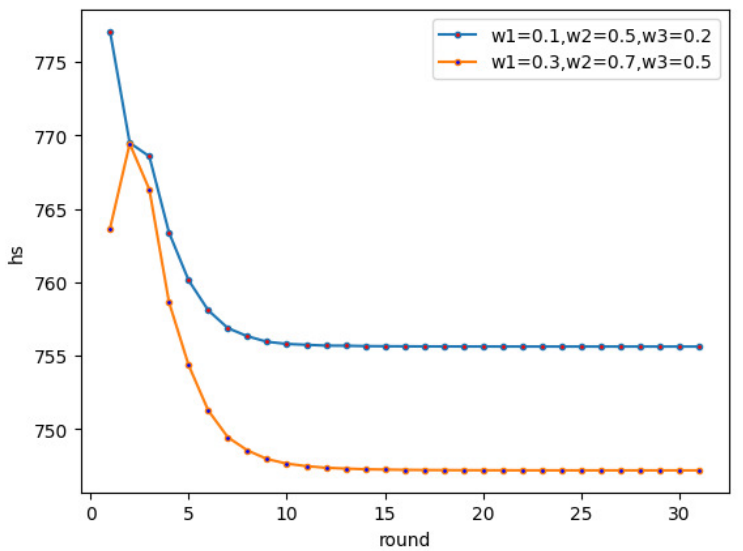
Figure 11. Effect of w 2 : h s changes with